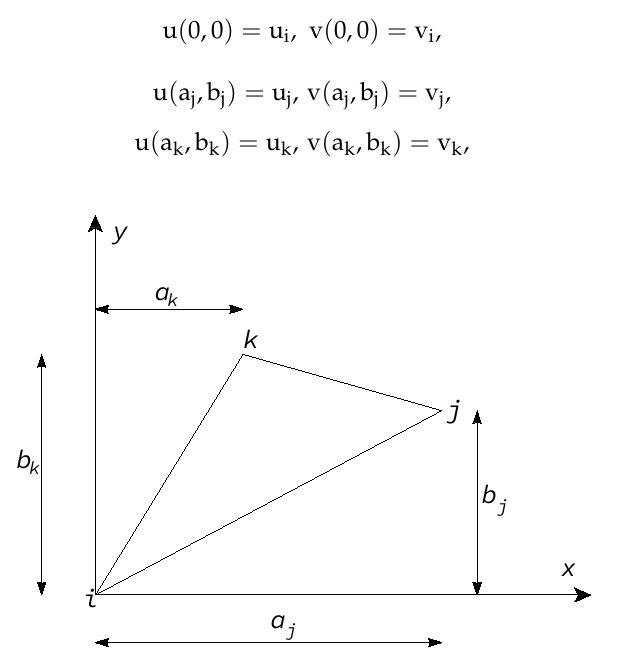
Figure 1. The triangular element.